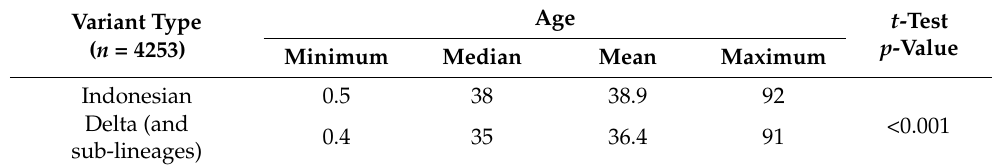
Table 5. Age distribution between Indonesian variants and Delta (including sub-lineages) in